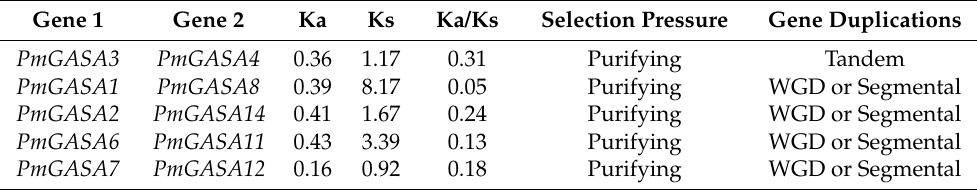
Table 3. The Ka/Ks ratios of paralogous gene pairs of PmGASA gene family.